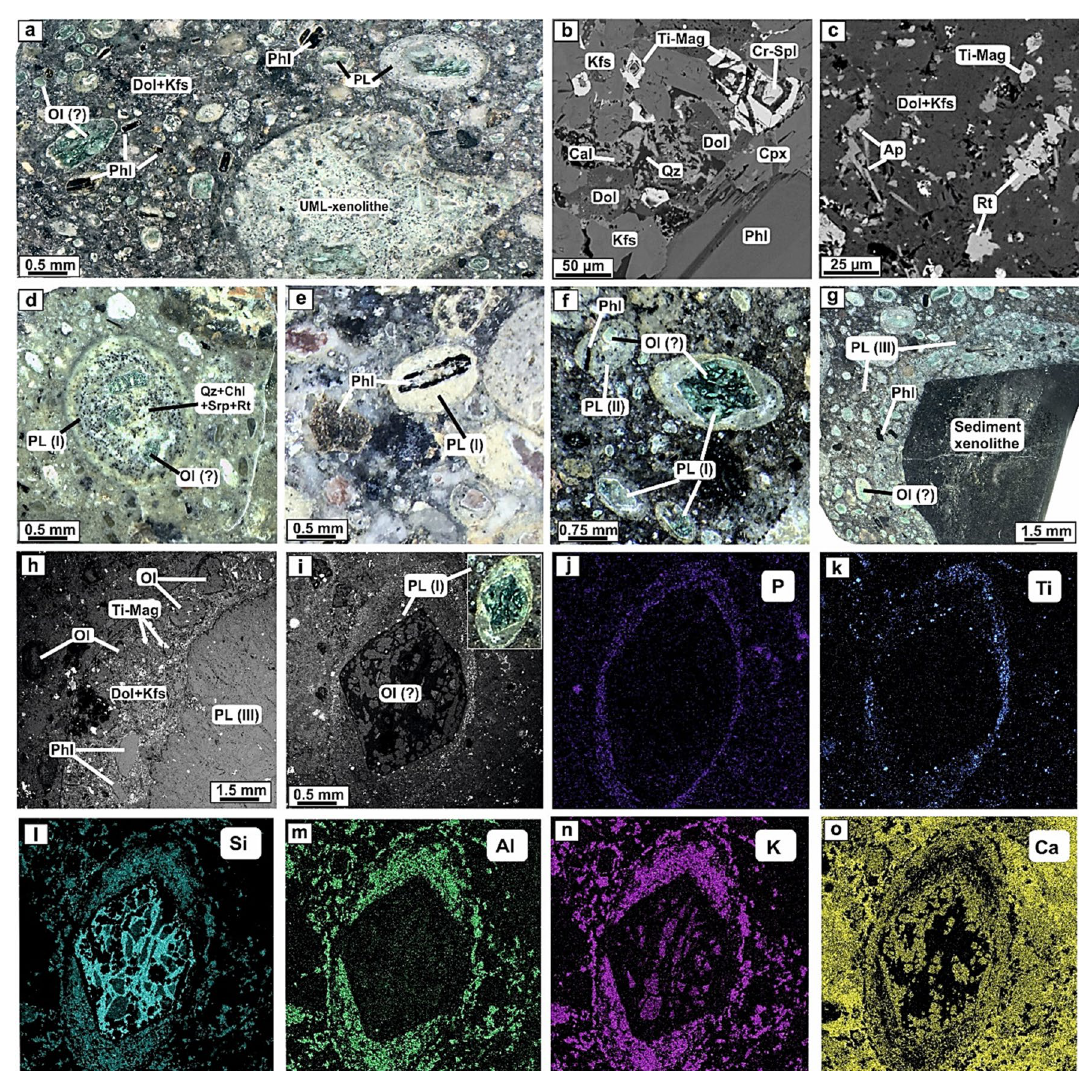
Figure 2. Photomicrographs ( a,d–g ) and back-scattered electron (BSE) images ( b,c,h,i ) of mineral assemblages of the Chadobets damtjernites with xenoliths of the earlier formed UML rocks (UML-xenolithe) and pelletal lapilli (PL) inclusions ( a ). Mineral composition of the damtjernites includes macrocrysts and phenocrysts of phlogopite (Phl) and olivine (Ol) within a groundmass of microphenocrysts of phlogopite, K-feldspar (Kfs) and dolomite (Dol), predominantly comprising clinopyroxene (Cpx), fluorapatite (Ap), Cr-spinel (Cr-Spl), Ti-magnetite (Ti-Mag) and rutile (Rt) crystals and grains ( b,c ). Pelletal lapilli type I (PL-I) contains olivine (Ol?) or phlogopite grains in in the cores, which are often completely replaced by quartz (Qz)-chlorite (Chl)- serpentine (Srp) with calcite (Cal) and rutile aggregates ( d–f ). The pelletal lapilli of the second type (PL-II) comprise two and or more minerals of phlogopite and olivine (Ol?) in the central area ( f ). The center of pelletal lapilli type III (PL-III) consists of lithic fragments of country rock or earlier alkaline pulses (xenoliths), whereas the rim of is represented by the damtjernites mineral assemblages ( g,h ). The mantle composition of PL-type I is shown on SEM elemental maps and includes P, Ti, Si, Al, K and Ca ( i–o